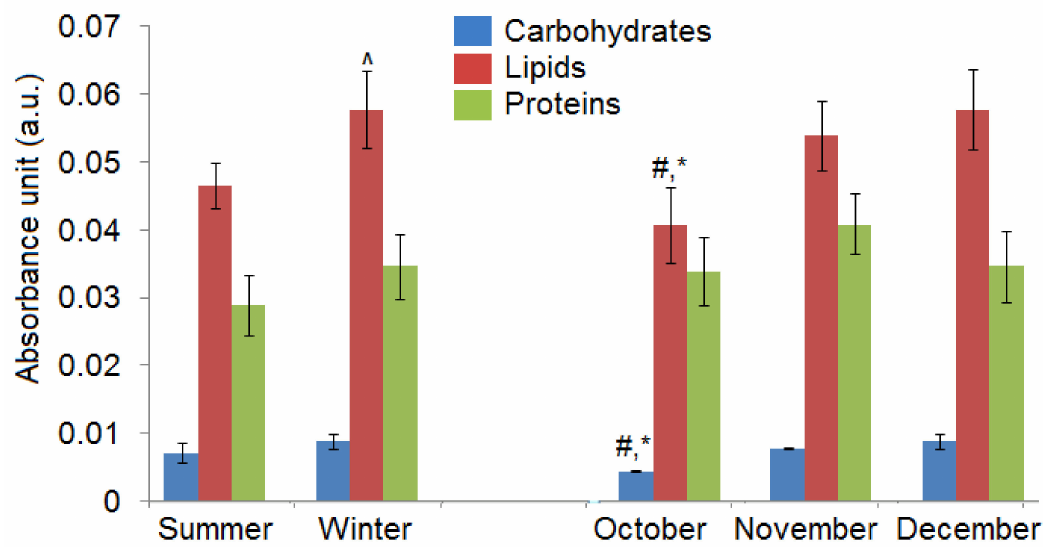
Figure 4. Sum of maximum absorbance of functional groups building carbohydrates (blue), lipids (red) and proteins (green). The differences are statistically significant between summer and winter (ˆ) and between October and November ( # ), October and December ( * ), ( p < 0.05, Tukey’s